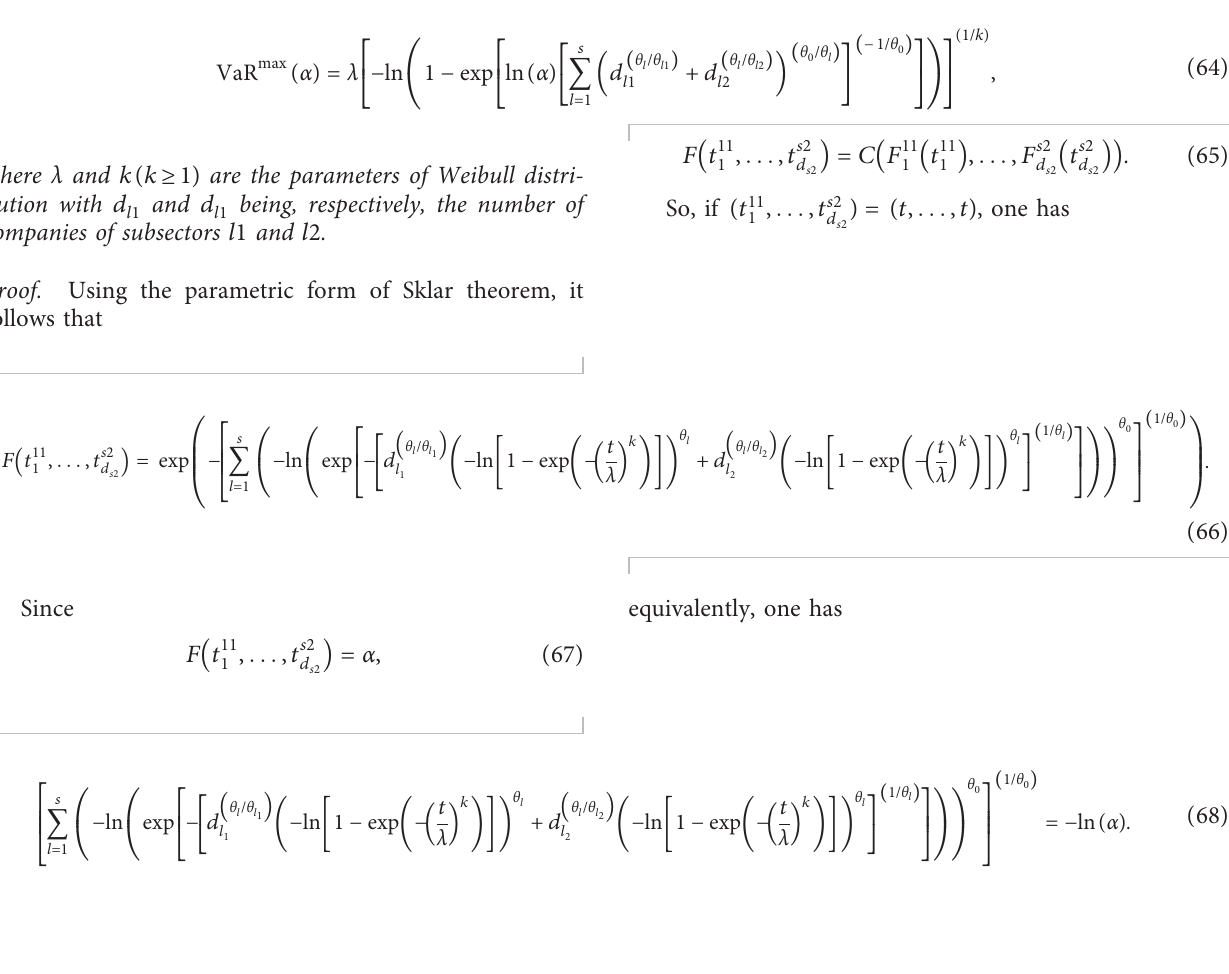
Figure 3: Maximum of the value at risk as a function of confidence level α for d i ∈ 1 , 2 { } in a